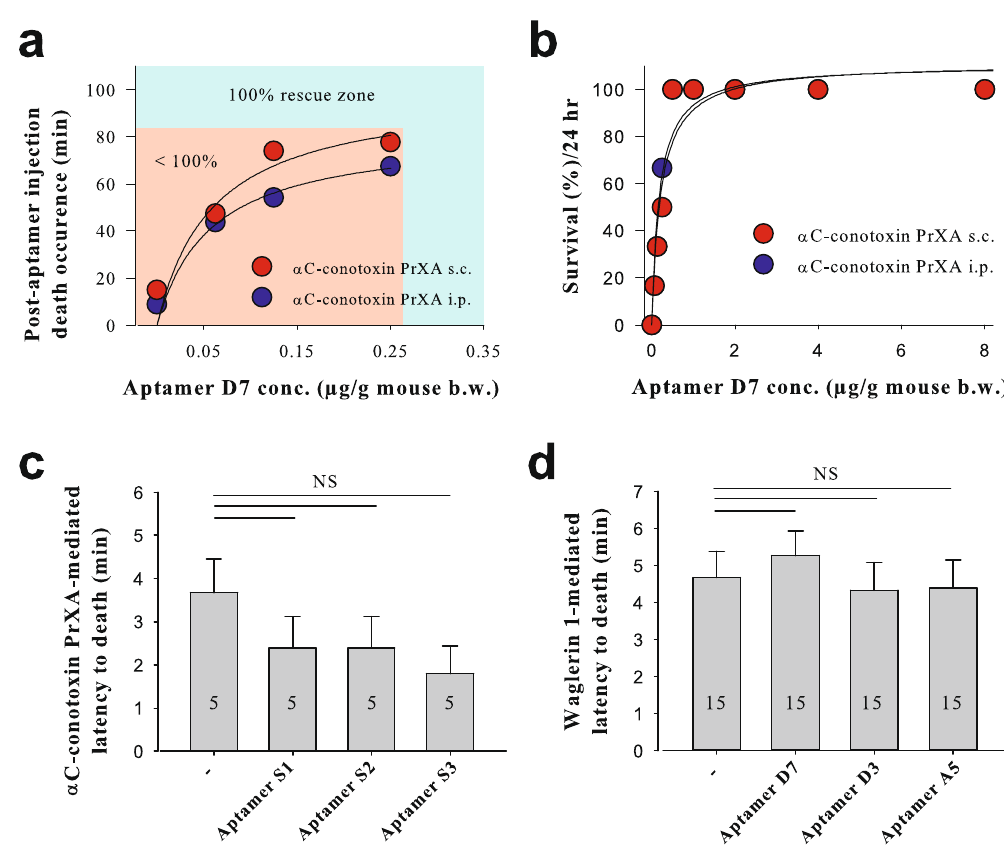
Figure 3. In vivo evaluation of aptamer neutralization properties. ( a ) Time of death of mice induced by 0.5 µ g toxin/g mouse b.w. as a function of D7 aptamer concentration. t = 0 min toxin injection (s.c. or i.p.), t = 1 min aptamer injection (i.v.). ( b ) Mice survival as a function of i.v.-injected D7 aptamer concentration. ( c ) Lack of effect of scramble oligonucleotides on α C-conotoxin PrXA-mediated death. ( d ) Lack of effect of D7, D3 and A5 aptamers on waglerin 1-mediated mice